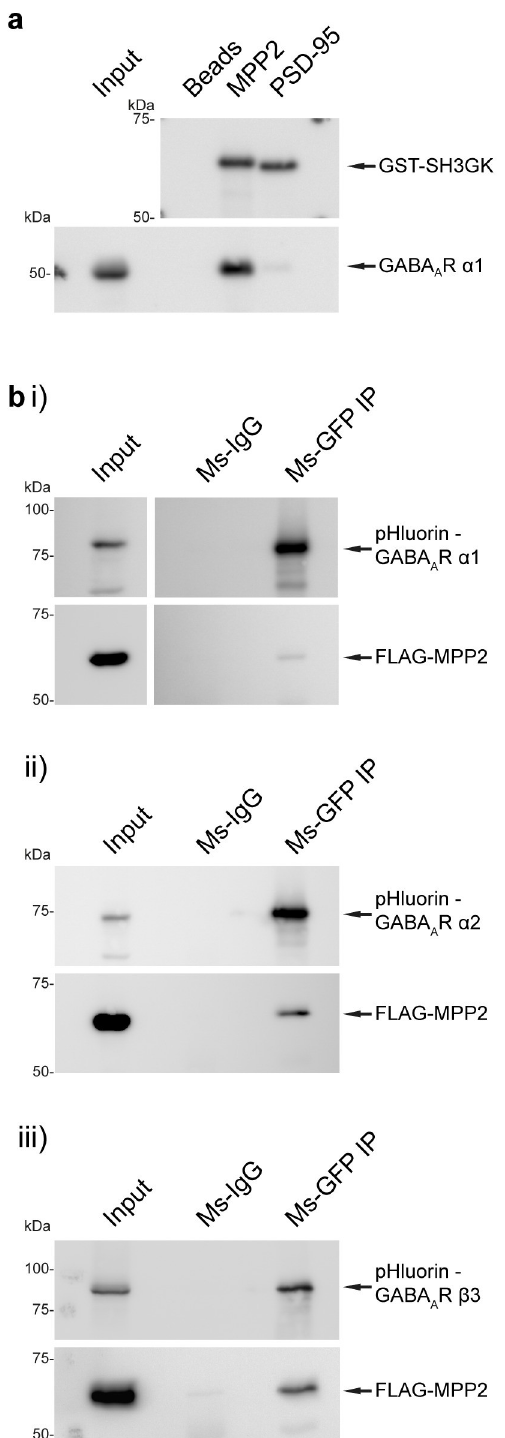
Fig 4. Validation of GABA A receptor subunits as novel interaction partners of MPP2. (a) Bacterially expressed GST-MPP2-SH3GK and GST-PSD-95-SH3GK were incubated with crude brain synaptosome preparations. After GST pull-down, compared to bead control, GABA A R α 1 was efficiently enriched in the GST-MPP2-SH3GK pull-down, as detected by western blot with α GABA A R α 1 and α GST antibodies. (b) GABA A receptor subunit constructs with an N- terminal pHluorin were acquired from Addgene and expressed in CHL V79 cells together with N-terminally